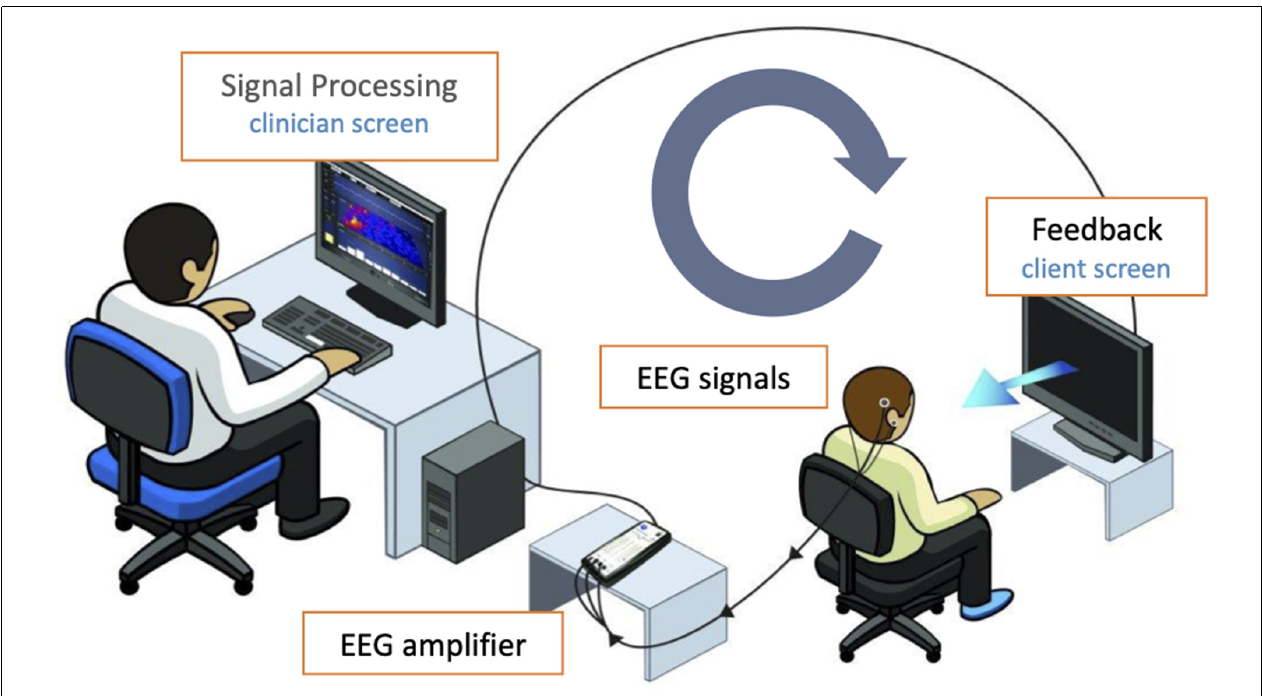
FIGURE 1 | Neurofeedback setup (image courtesy of BEE Medic